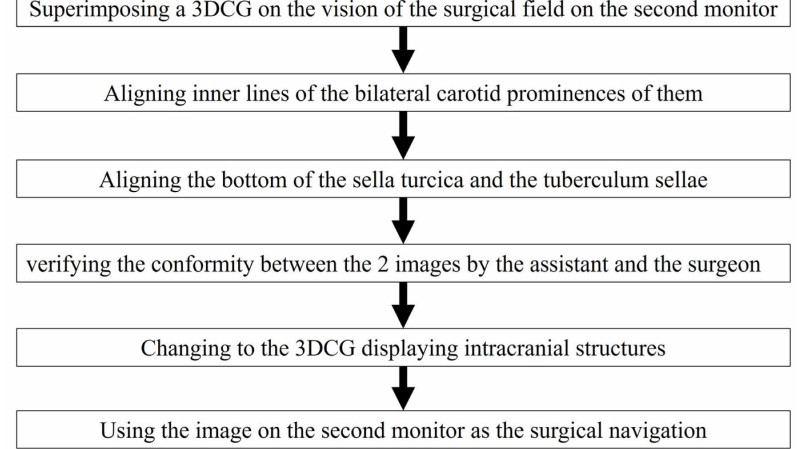
Figure 3. Flow chart for aligning the 3DCG with the vision of the surgical